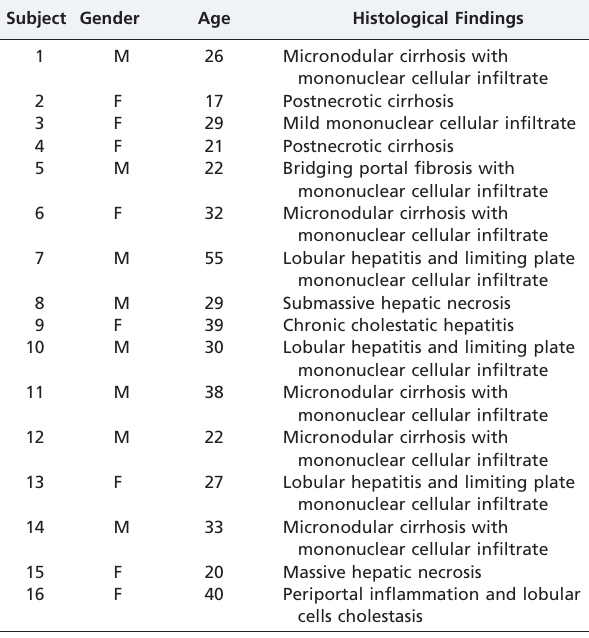
Table 2 - Hepatic Histological Findings (n=